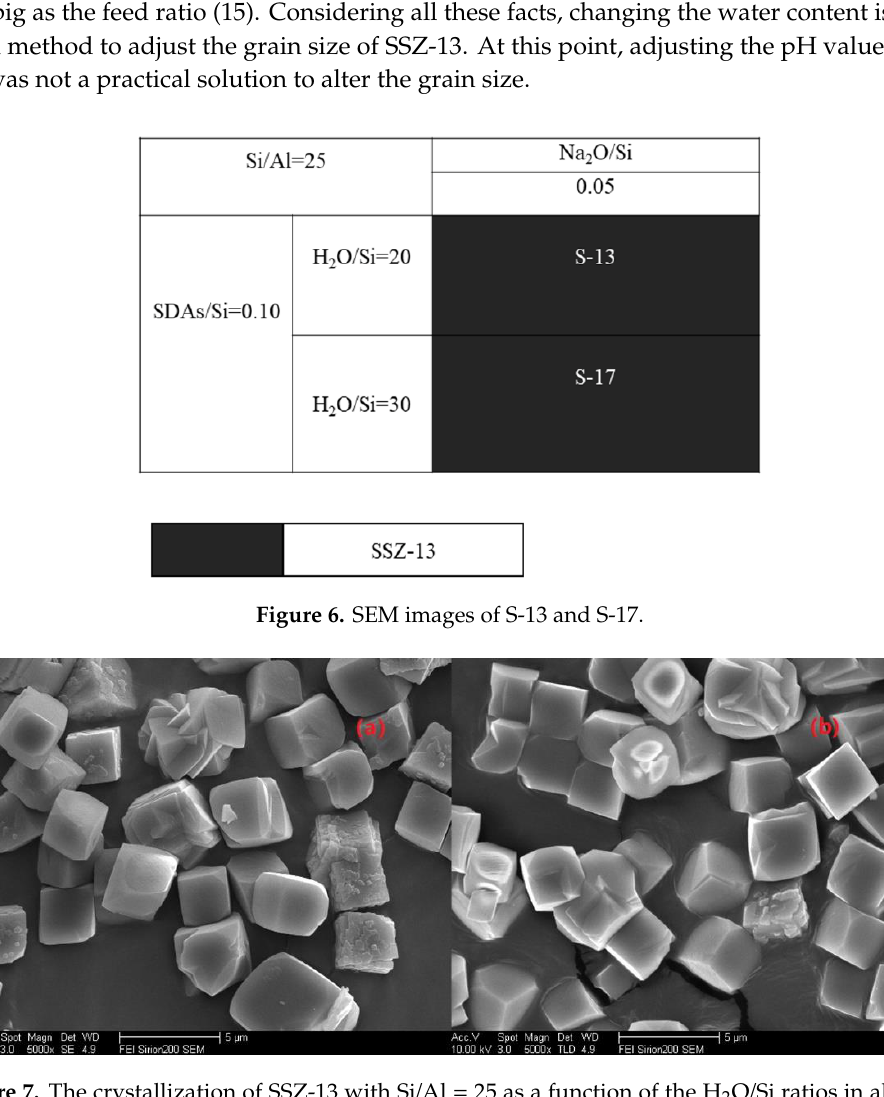
Figure 7. The crystallization of SSZ-13 with Si / Al = 25 as a function of the H 2 O / Si ratios in alkaline media. ( a ) S-13; ( b ) S-17. Table 3. Si / Al ratios for the obtained SSZ-13s.